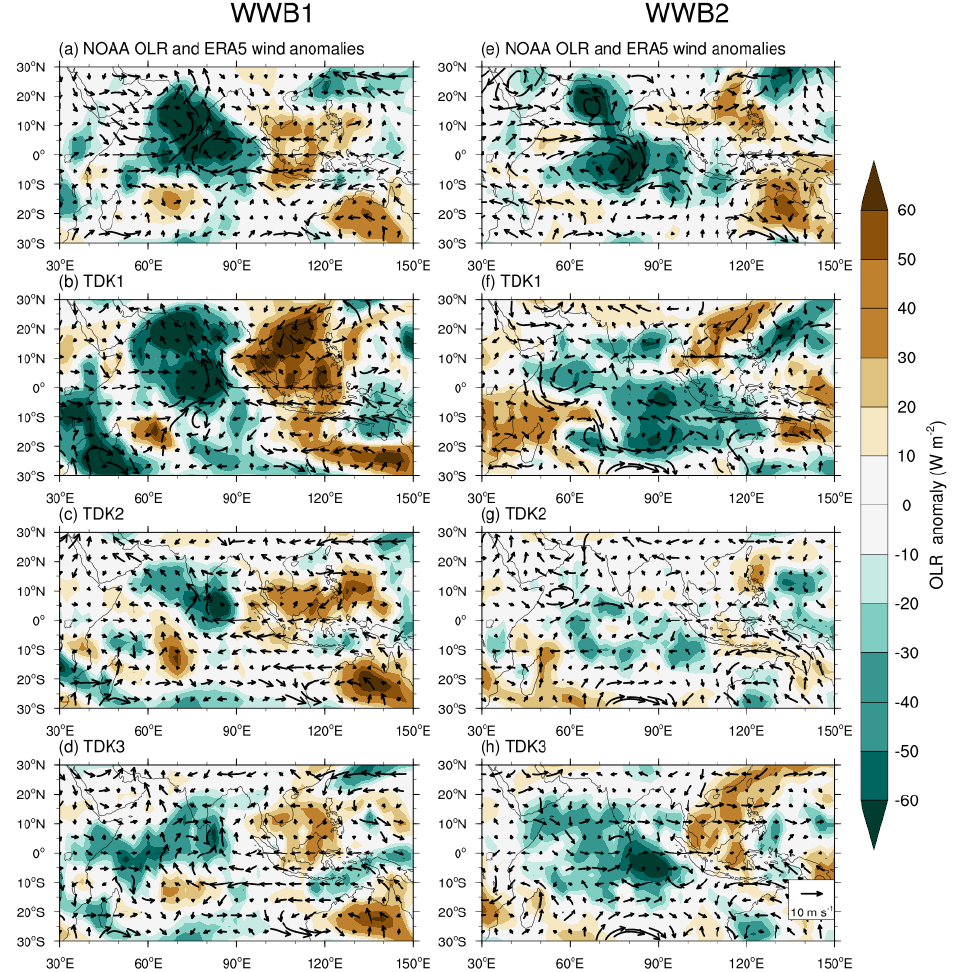
Figure 3. Horizontal structure of the two MJO events. Composite 850 wind anomalies (vectors, 10 m s −1 ) are derived from ( a , e ) ERA5, ( b , f ) TDK1, ( c , g ) TDK2, and ( d , h ) TDK3. Two-day averaged results are shown in the left (right) panels when the WWB1 (WWB2) convective center is located near 90° E. The selected time range of the WWB1 is 22 to 23 November 2011. For the WWB2, the time range is 27 to 28 (28 to 29) November 2011 in the ERA5 and the TDK1 (the TDK1 and TDK2 experiments). The shading indicates the OLR anomaly (W m −2 ). NOAA OLR anomaly (shading, W m −2 ) is displayed in ( a , e ). ERA5 product and model results have been interpolated to the coarser resolution of NOAA OLR.